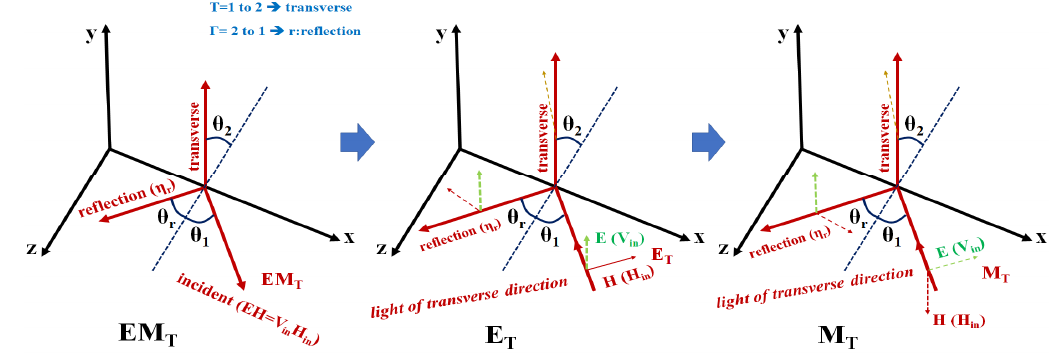
Figure 4. Propagation of electromagnetics for light reflection and transvers.